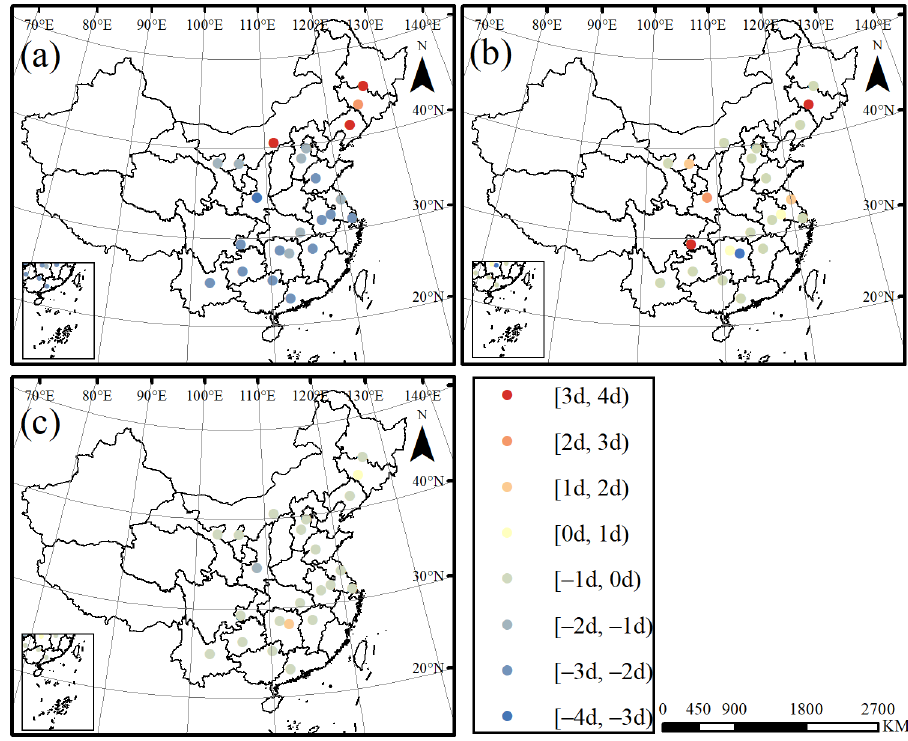
Figure 7. Spatial distribution map of ( a ) RNN, ( b ) LSTM, and ( c ) GRU prediction error.